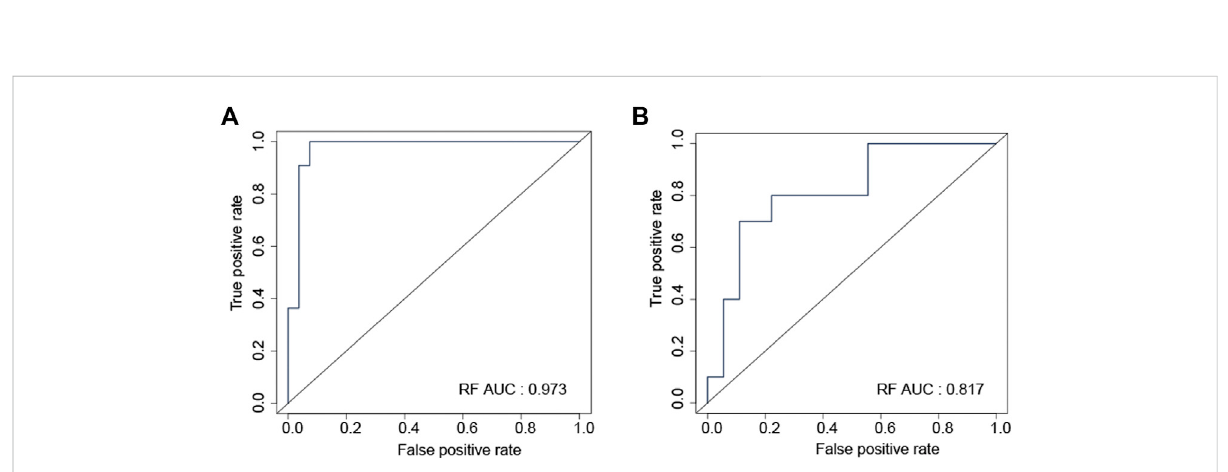
FIGURE 6 ROC curve validated the sensitivity and speci fi city of random forest model for distinguishing EGFR-TKI resistant and sensitive samples in the internal testing (A) and the external testing (B) datasets.